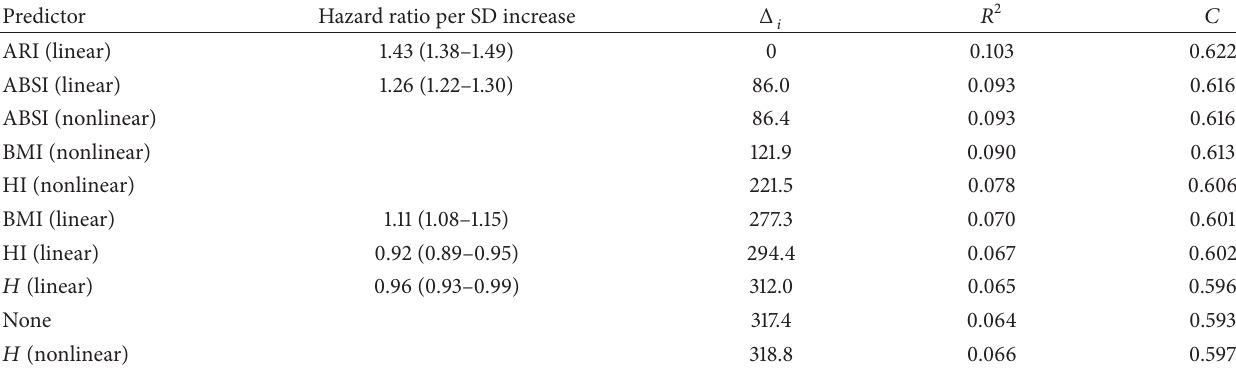
Table 5: Mortality hazard association with body measures in